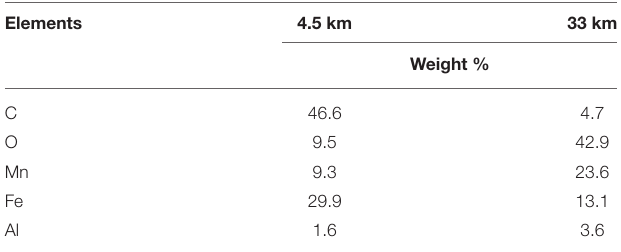
TABLE 3 | Elements present in biofilm samples obtained 4.5 and 33km downstream from the LBIS 1 extraction point in February 2017, as identified through